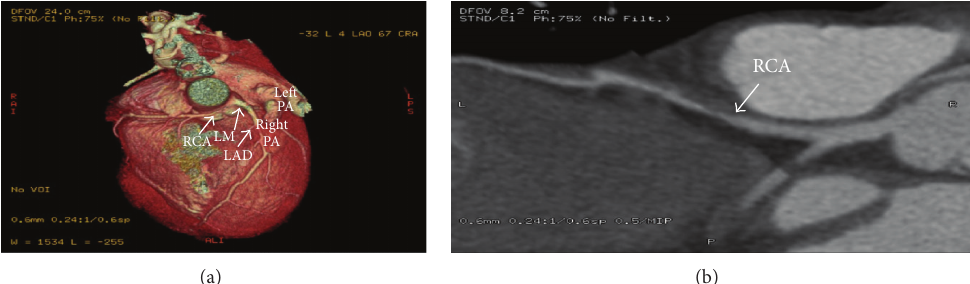
Figure 1: (a) Cardiac CT angiography with 3D reconstruction with digital subtraction of pulmonary arteries. (b) Cardiac CT angiography.